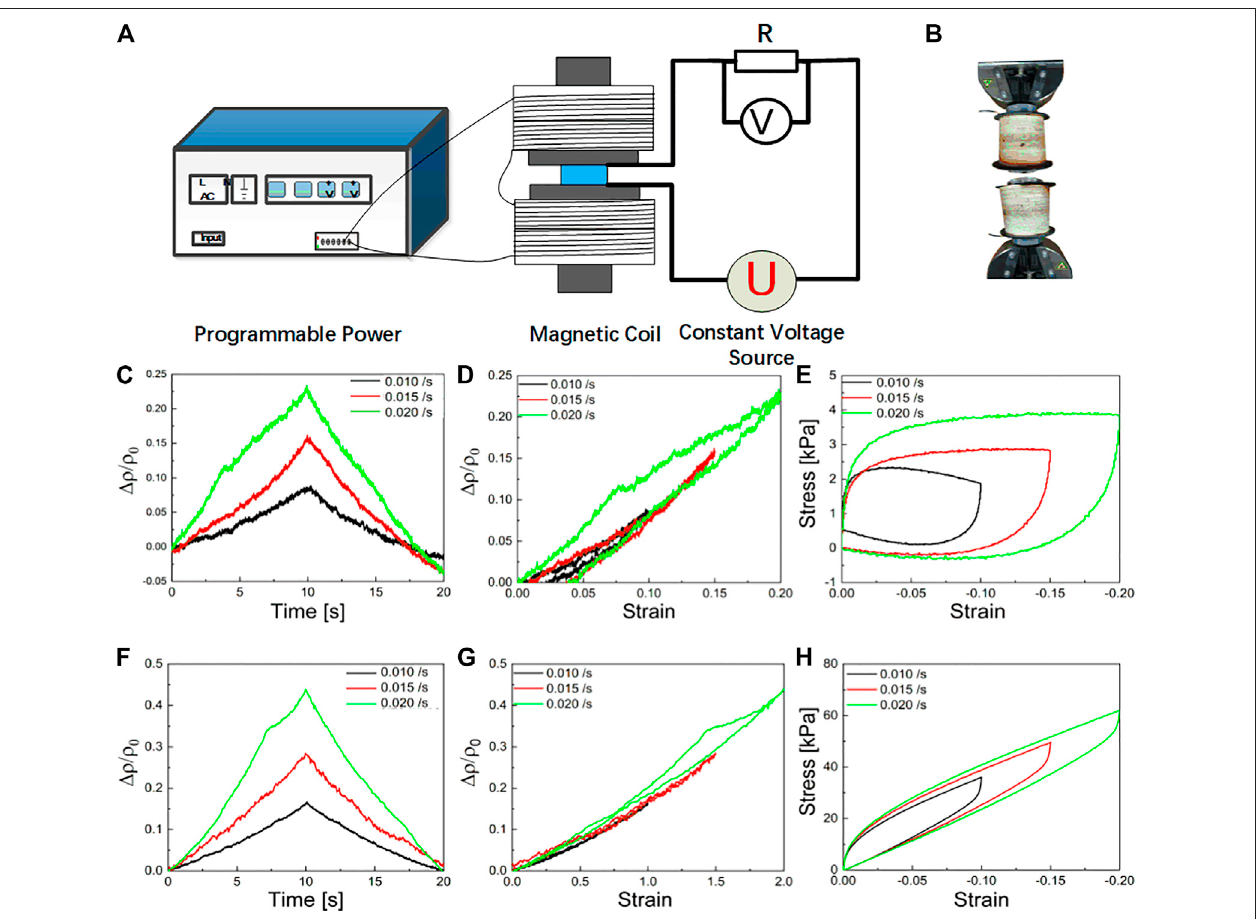
FIGURE 3 | (A) Schematic of the test equipment and the measuring method. (B) The testing equipment. (C – E) The electrical resistivity behaviors vs. time and compressive strain, the stress-strain without magnetic fi eld. (F – H) illustrated the behaviors under a magnetic fl ux density of 0.3 T.